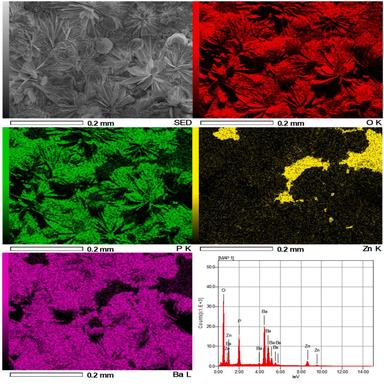
SEM mapping analysis of BHP@ZnO thin film.